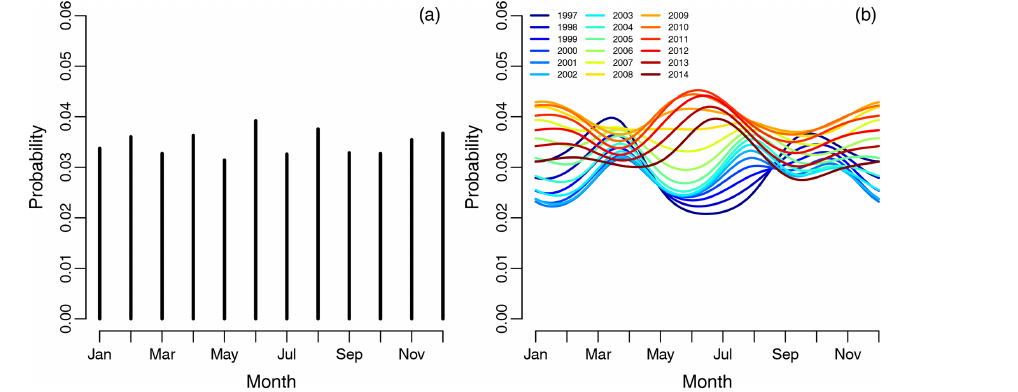
Figure 4. (a) The empirical risk of revision for any reason for each month averaged over the years. Each line represents 1 calendar month. (b) The spline regression model showing the probability of revision for any